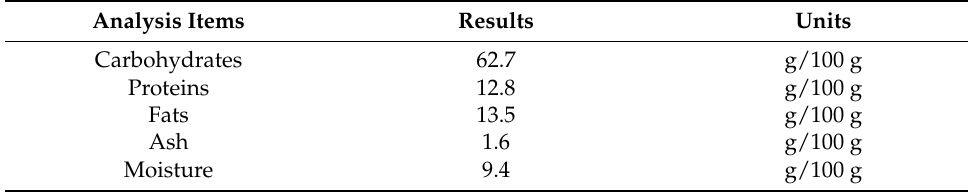
Table 2. Chemical composition of spent coffee grounds.